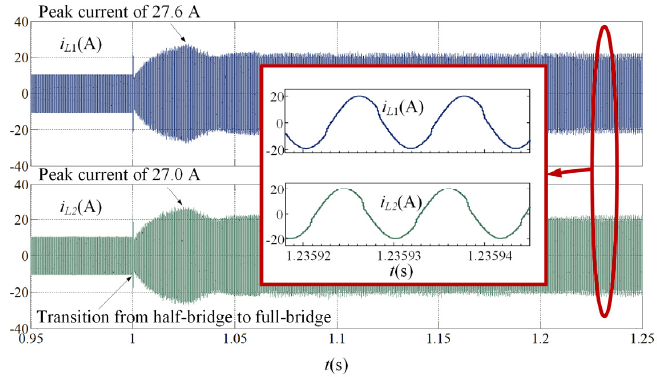
Figure 15. Two channel LLC currents in off-line mode during load transition from 0 to 7 kW.